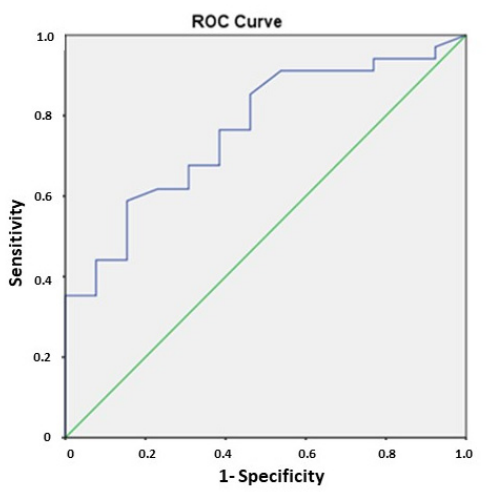
Figure 2. Correlation between fecal calprotectin levels and severity of inflammation measured with Lewis score.